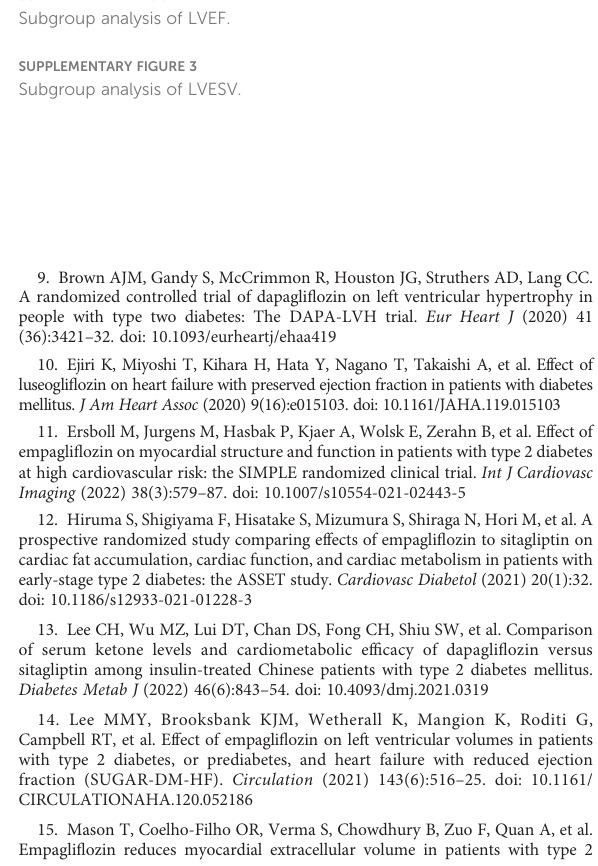
SUPPLEMENTARY FIGURE 2 Subgroup analysis of LVEF. SUPPLEMENTARY FIGURE 3 Subgroup analysis of